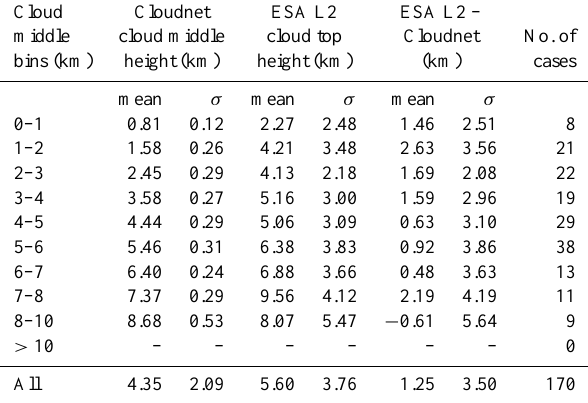
Table A8. Comparison of SCIAMACHY ESA L2 cloud top height with Cloudnet cloud middle height for multilayer